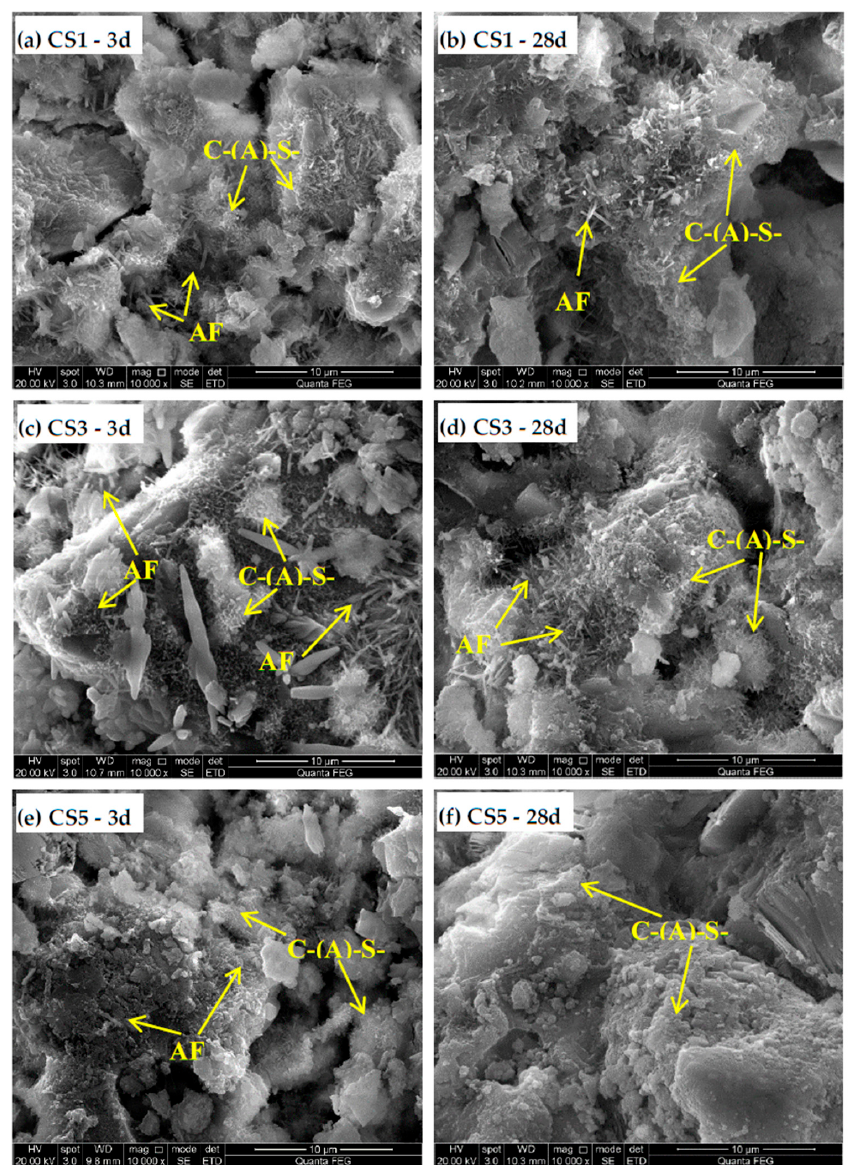
Figure 14. Scanning electron microscope (SEM) micrographs of hydrated slag pastes at 3 and 28 days. ( a ) CS1 at 3 days; ( b )CS1 at 28 days; ( c ) CS3 at 3 days; ( d ) CS3 at 28 days; ( e ) CS5 at 3 days; ( f ) CS5 at 28 days.